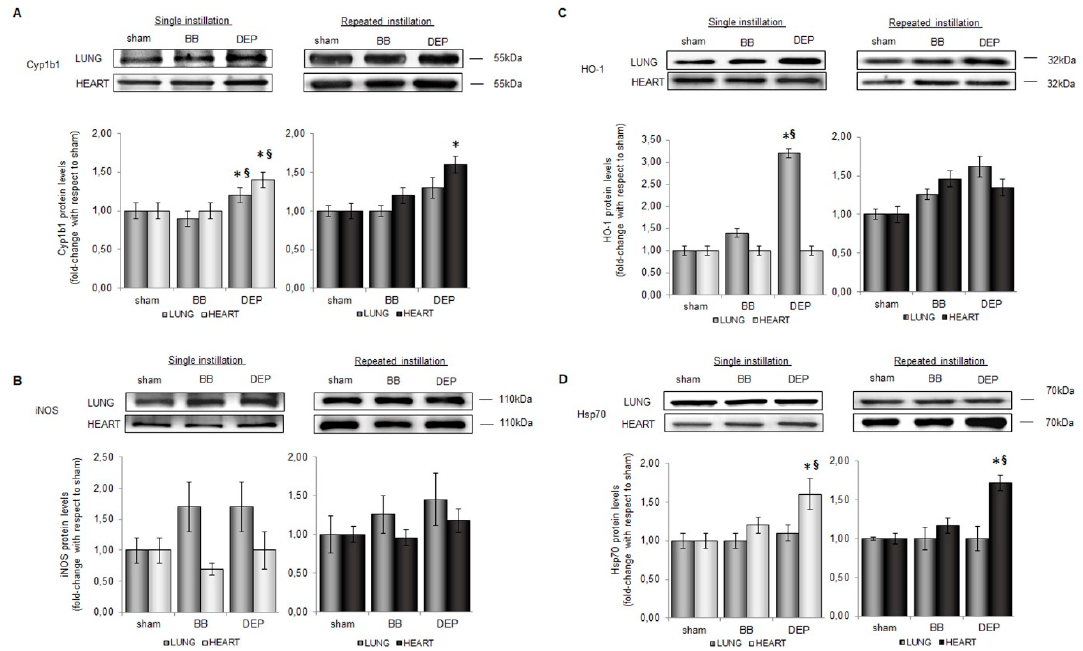
Figure 6. Oxidative stress markers protein levels in lung and heart parenchyma. Representative immunoblotting images of Cyp1b1 ( A ), iNOS ( B ), HO-1 ( C ), Hsp70 ( D ), in lung and heart parenchyma after single and repeated instillations with 50 µ g of BB or DEP / 100 µ L 0.9% NaCl. Histograms display Cyp1b1, iNOS, HO-1 and Hsp70 as fold-change with respect to sham. Proteins have been normalized for corresponding total proteins revealed by Ponceau staining in each lane and the data are expressed as mean ± s.e.standard error ( n = 6). Statistical differences were tested accordingly by One-way ANOVA followed by Bonferroni post-hoc comparison. * p < 0.05 vs. sham mice; § p < 0.05 vs. BB. Differently, analysis of inducible nitric oxide synthase (iNOS), a pro-oxidant protein involved in